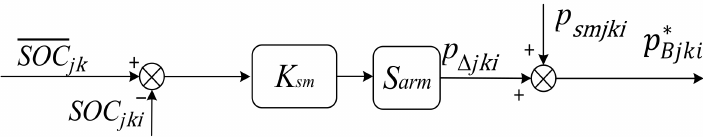
Figure 6. The individual submodule SOC balancing